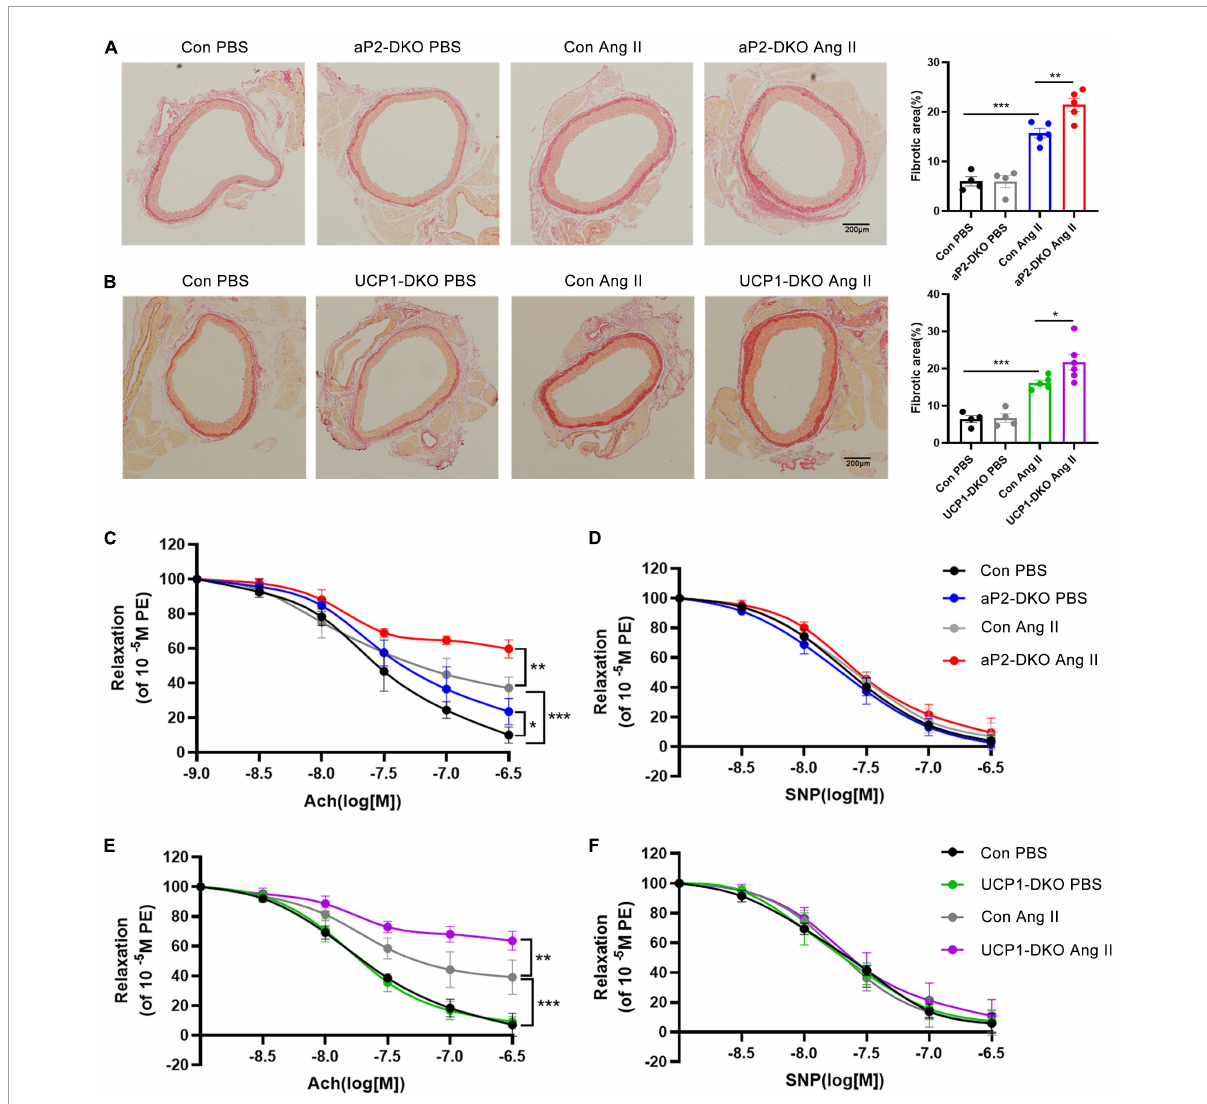
FIGURE3 Deficiency of bone morphogenetic protein 4 (BMP4) in perivascular adipose tissue (PVAT) aggravates Ang II-induced vascular injury. Male the control, aP2-DKO and UCP1-DKO mice were infused with PBS or Ang II. (A) Sirius-red staining of thoracic aorta (left) and the percentage of fibrotic areas (right) were calculated. (B) Sirius-red staining of thoracic aorta (left) and the percentage of fibrotic areas (right) were calculated. (C) Concentration-response curves of endothelium-dependent (ACh) relaxation. (D) Concentration-response curves of endothelium-independent (SNP) relaxation. (E) Concentration-response curves of endothelium-dependent (ACh) relaxation. (F) Concentration-response curves of endothelium-independent (SNP) relaxation. Values are means ± S.E.M. * P < 0.05, ** P < 0.01, and *** P < 0.001 by one-way analysis of variance (ANOVA) (A,B) or two-way analysis of variance (ANOVA) (C–F)